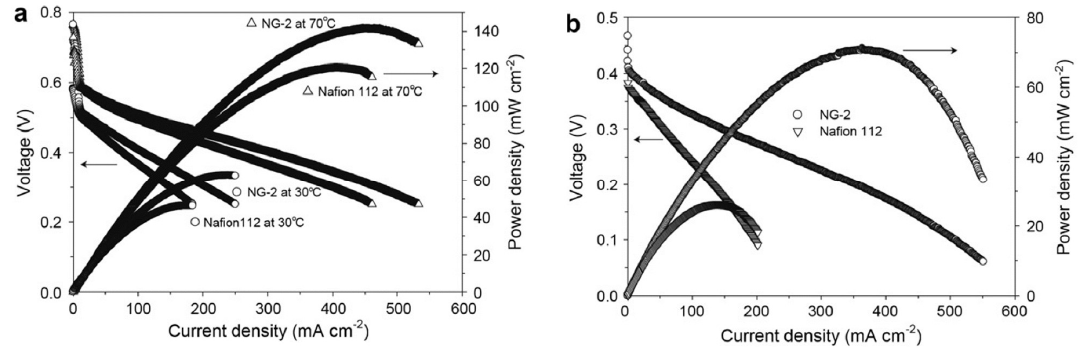
Figure 2. Polarization curves of DMFC obtained for Nafion 112 and GO composite membranes at ( a ) 1M methanol at 30 ◦ C and 70 ◦ C and ( b ) 5M methanol at 30 ◦ C; reproduced with permission from